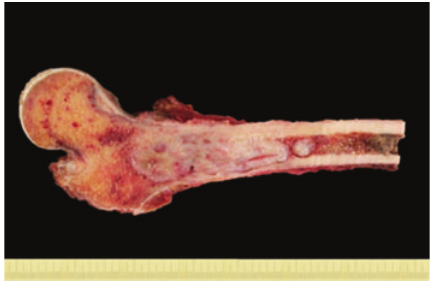
Figure 2: The explant shows a proximal femur measured 25cm in length, a tumor of 10 cm in max. dimension and predominantly grey-white appearance occupies the medullary